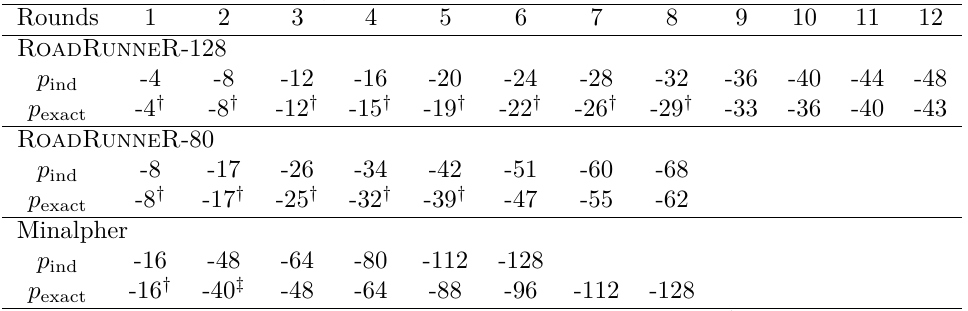
Table 1: Improved probability of characteristics for RoadRunneR -128 and